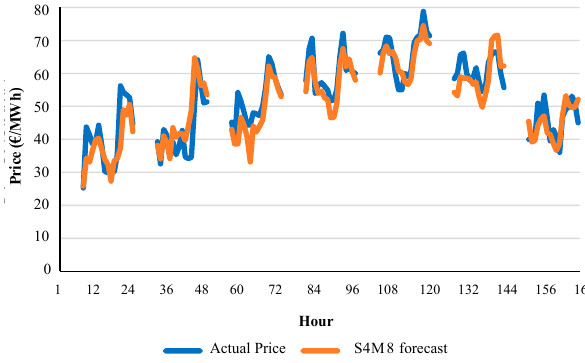
Figure 10. Actual price values and forecast values of model S4M8 of intraday session 4 for week 7 of year 2013.